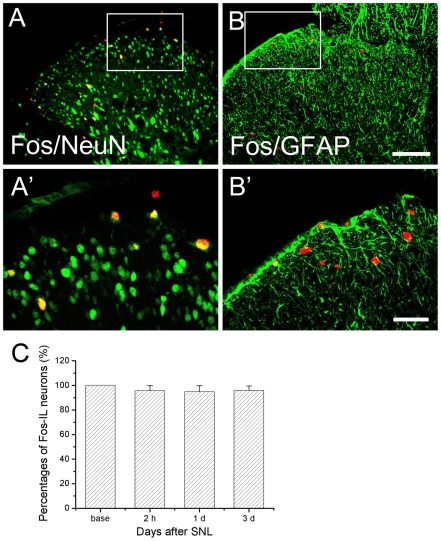
Double immunofluorescence for Fos (red)/NeuN (green) and Fos (red)/GFAP (green) in the ipsilateral dorsal horn 3 d after SNL.A' and B' are the magnified images of the rectangles indicated in the above top panels in A and B, respectively. Double immunofluorescence indicated that few GFAP-IR astrocytes were Fos positive (shown by double arrowheads in B'), while most of them were nuclei of activated neurons (shown by double arrowheads in A'). These activated neurons and astrocytes were mainly distributed in the superficial layer of dorsal horn, and the Fos-positive neurons were surrounded with many GFAP-positive astrocytic processes formed close relationship with each other. The figures shows representative photomicrographs obtained from a minimum of three independent experiments. Fos and NeuN double labeled neurons observed in the ipsilateral superficial dorsal horn were counted and the proportion of double labeling neurons in total Fos positive cells were calculated. The statistical results of these comparisons are presented in C. Scale bar = 200 µm in A, B and 80 µm in A' and B'.